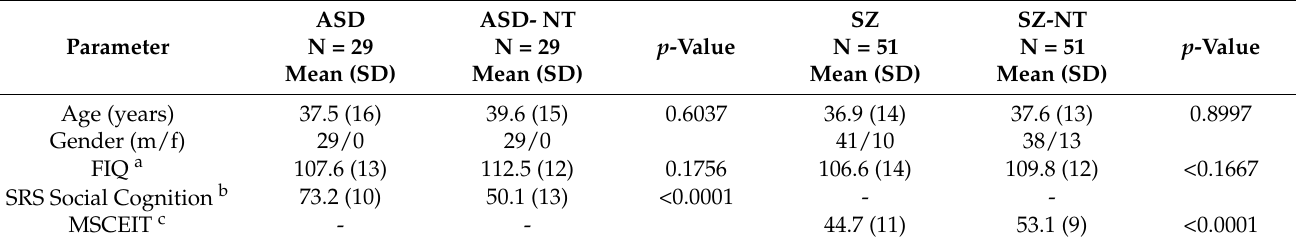
Table 2. Demographics and Clinical Characteristics of ASD, SZ and